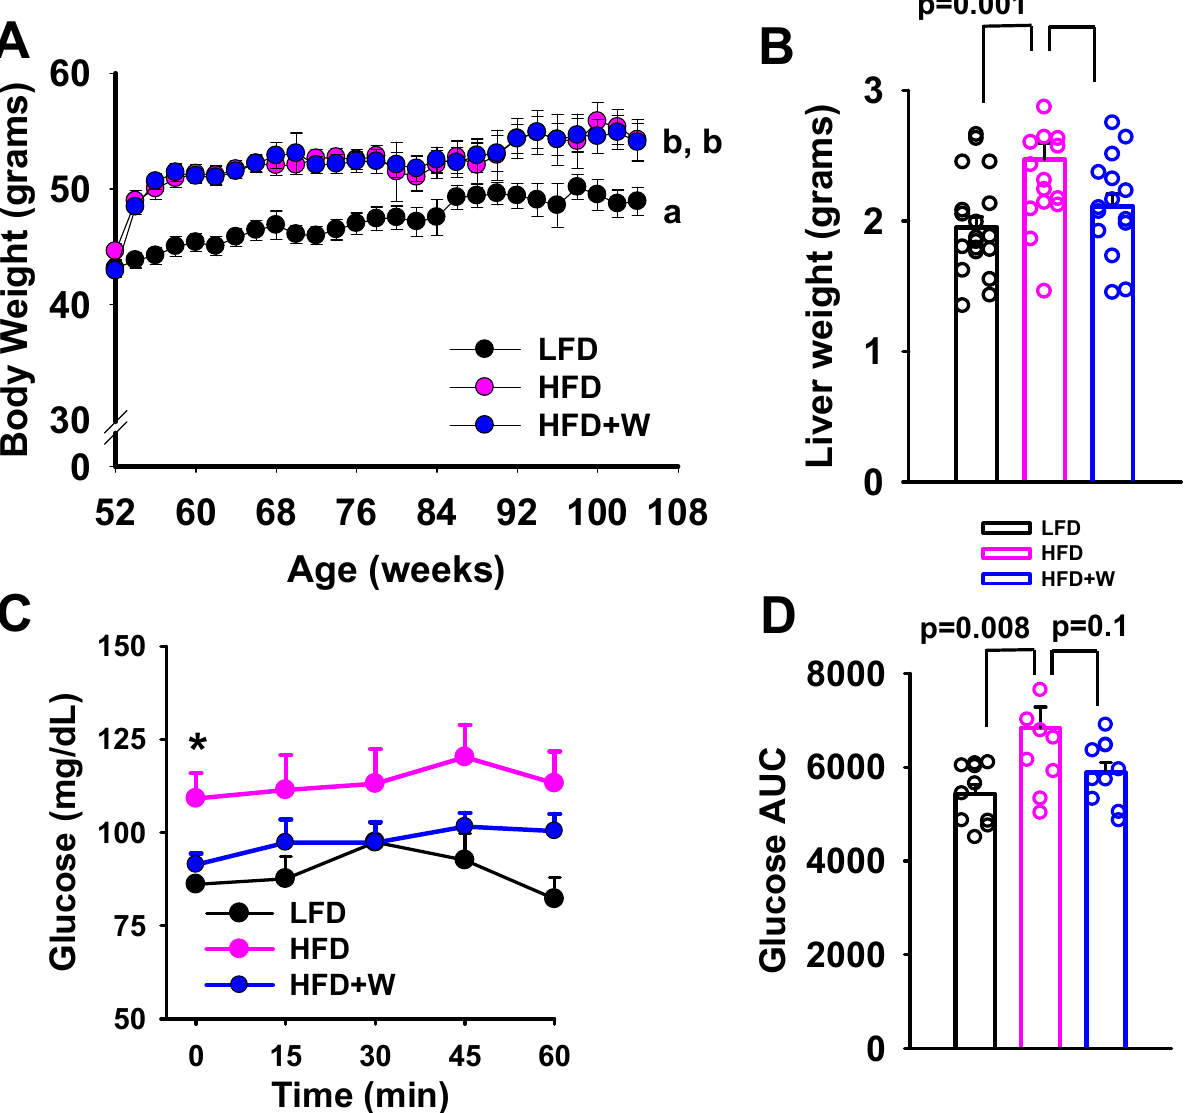
Figure 1. Effect of dietary walnuts on body weight and insulin sensitivity in HFD-fed male CB6F1 mice. ( A ) Male CB6F1 mice demonstrated similar weight gain over 1 year when placed on either the HFD or HFD supplemented with 7.67% walnuts (HFD + W) at 12 mo of age, which was significantly heavier than LFD controls ( n = 15 per group). ( B ) Excised liver weights following ~7 mo on diet at 19 mo of age ( n = 16–19 per group). ( C , D ) Insulin tolerance tests were also performed (1 mU/kg) at ~18 mo of age and blood glucose levels were monitored over 60 min after injection ( n = 10 per group). While all groups of aged CB6F1 mice demonstrated marked insulin resistance, as demonstrated by a failure of insulin to suppress glucose levels, levels remained most elevated in HFD-fed mice, which is reflected in a significantly higher glucose area under the curve (AUC). Line and bar graphs represent mean ± SE.* Significantly different from LFD and HFD + W, p ≤ 0.05. Dot plots overlaid on bar graphs represent individual data points. Different letters denote a significant difference between groups by Tukey HSD, p ≤ 0.05.